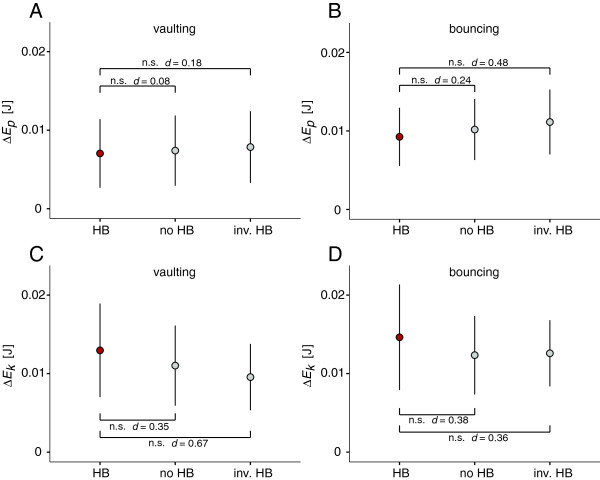
Mean amplitude (± s.d.) ofEpandEkfluctuation (ΔEpandΔEk) in experimental trials (HB), simulated trials without head-bobbing (no HB) and simulated trials with inversely timed head-bobbing behavior (inv. HB). A: ΔEp in vaulting trials; B: ΔEp in bouncing trials; C: ΔEk in vaulting trials; D: ΔEk in bouncing trials.